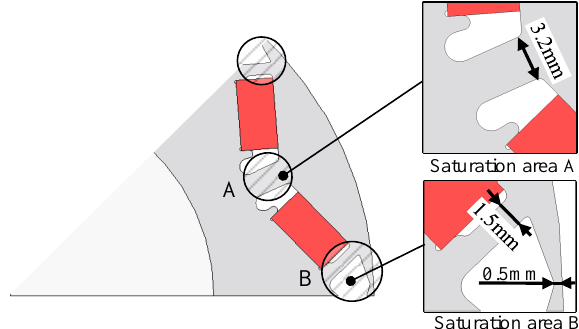
Figure 11. Magnetic saturation areas of prototype motor.